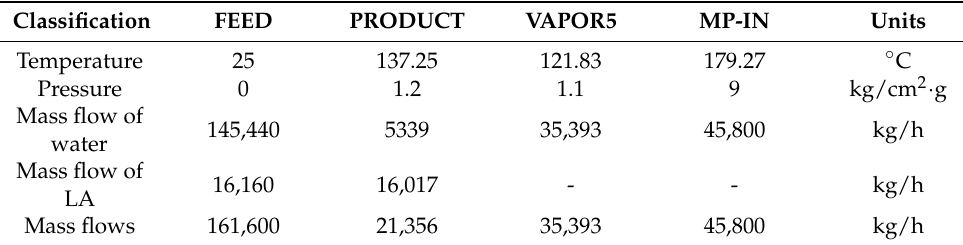
Table 5. Simulation results for alternative evaporation process using